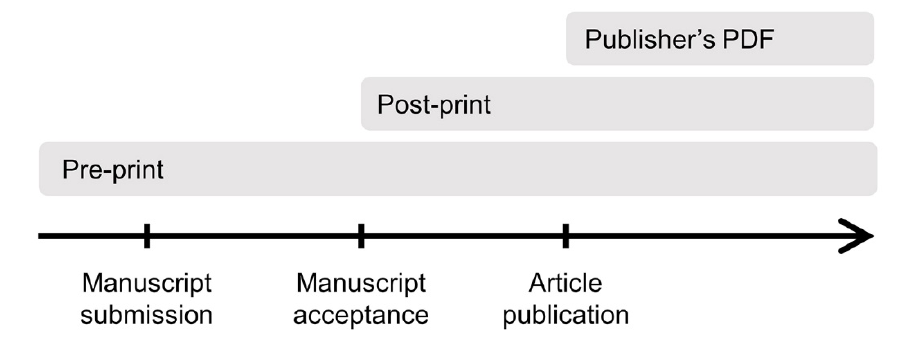
Figure 1 Versions of a manuscript that can be self-archived at different stages of the writing and publishing